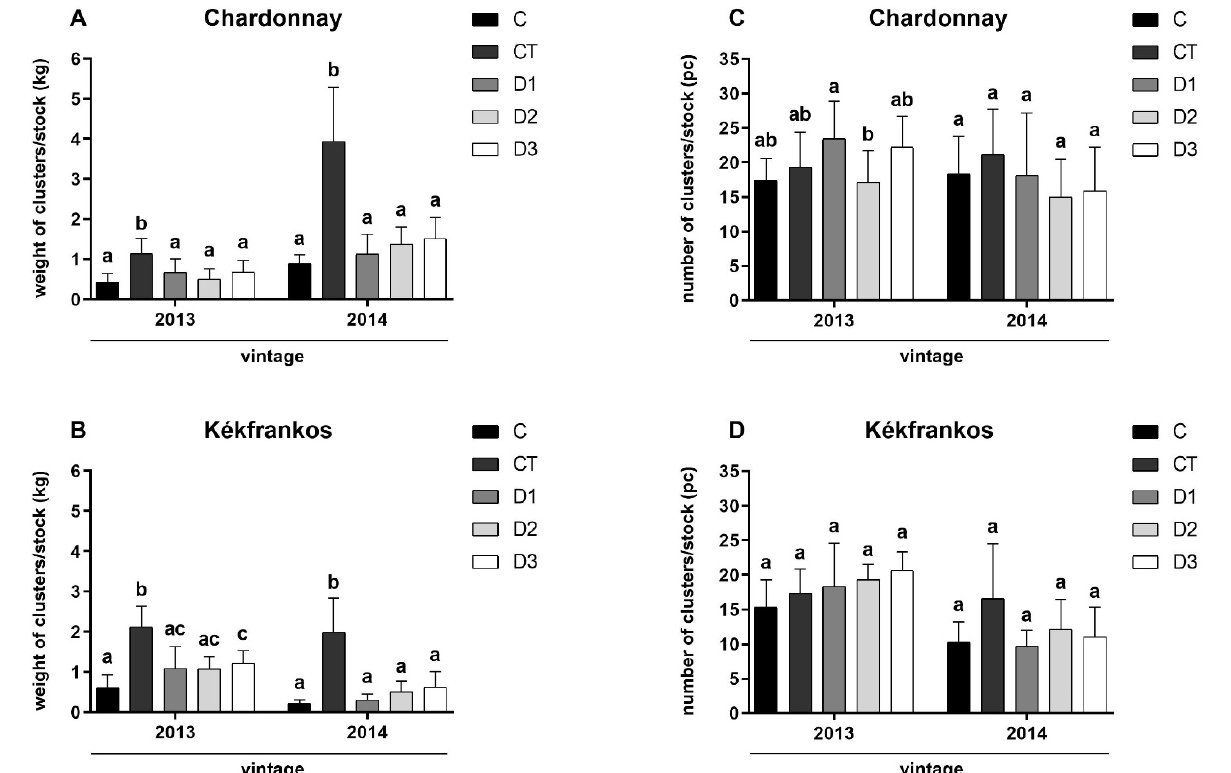
Figure 6. ( A – D ) Weight of clusters/vine stock ( A , B ) and the number of clusters/vine stock ( C , D ) of Chardonnay ( A , C ) and Kékfrankos ( B , D ) cultivars in 2013 and 2014. The colored bars of treatments indicate untreated (C) or treated with 1.1, 2.2, or 3.3 v/v% PFO (D1, D2, and D3, respectively). Columns represent the average data of nine stocks, and error bars show the standard deviation (SD).